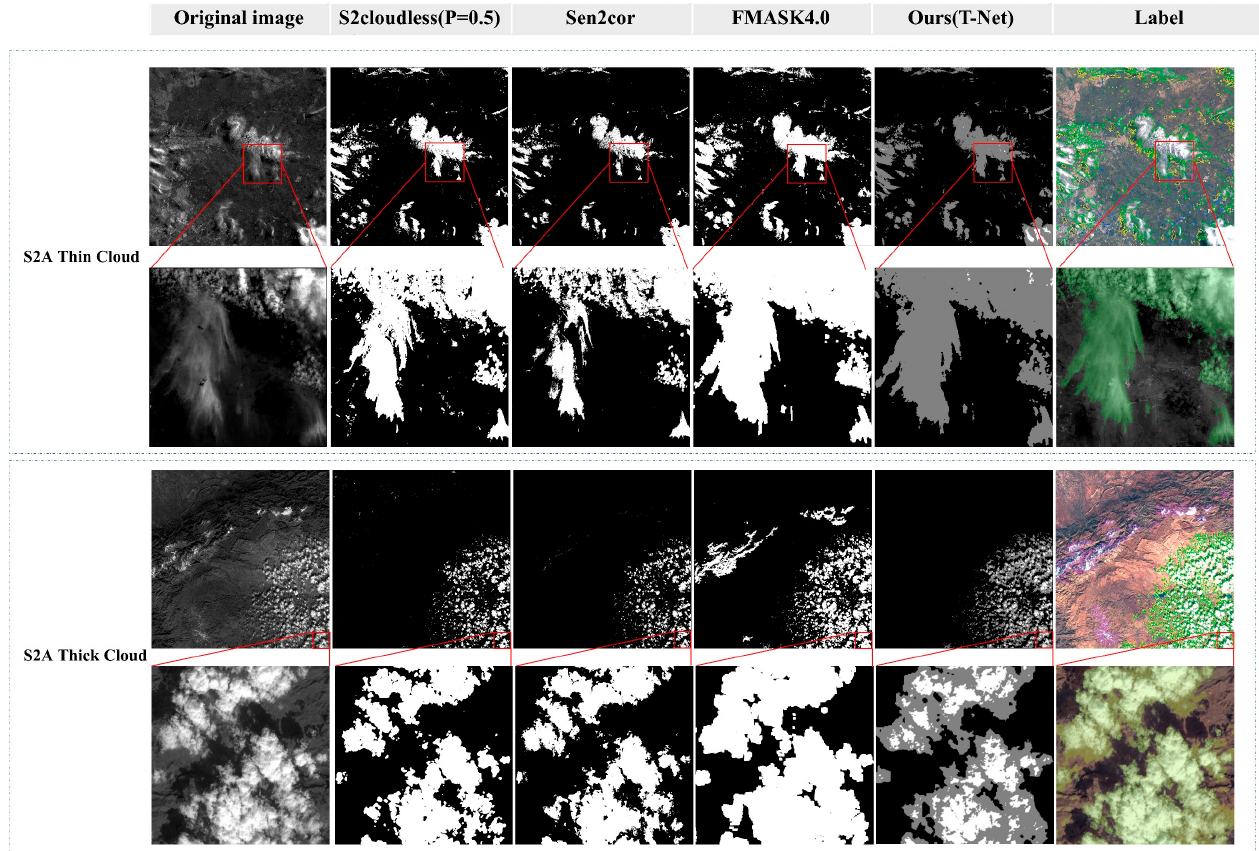
Figure 5. Cloud detection comparison experiments. The first to sixth columns are Band-2 image information, S2cloudless cloud detection results with a probability greater than 0.5, Sen2cor-2.09 cloud detection results, FMASK4.0 cloud detection results, T-Net trisection prediction results, and ALCD Tags.